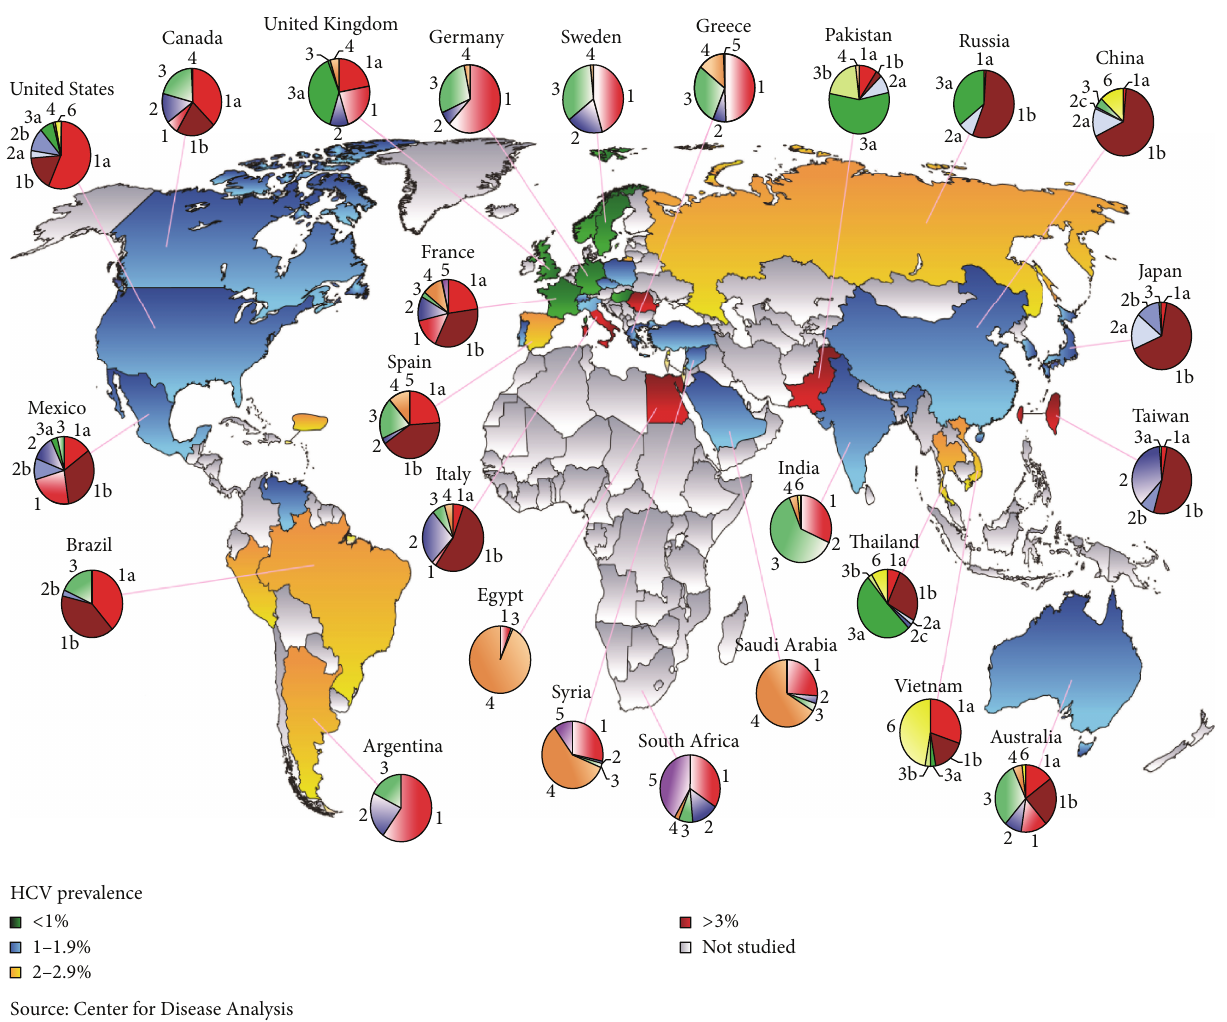
Figure 1: HCV prevalence among adults and genotype